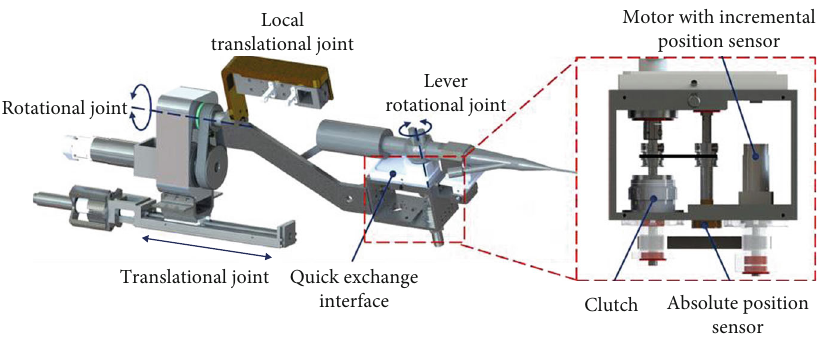
Figure 7: The 3-DoF operational mechanism for ureteroscope.